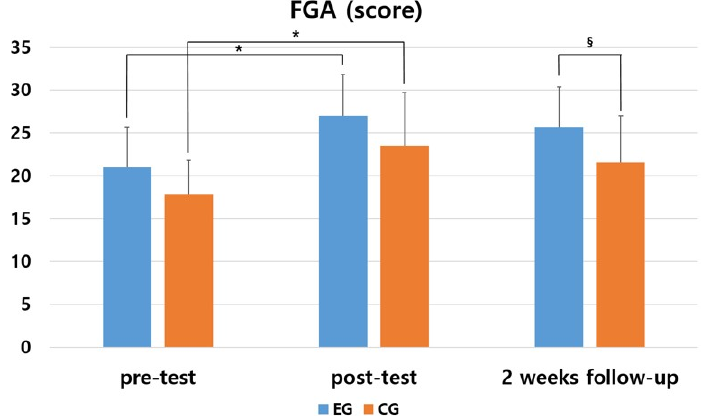
Figure 3. Comparison of the changes of within and between groups in FGA. * means a statistical significance within the group as compared to pre ( p < 0.05). § means a statistical significance by measurement period between groups ( p < 0.05).